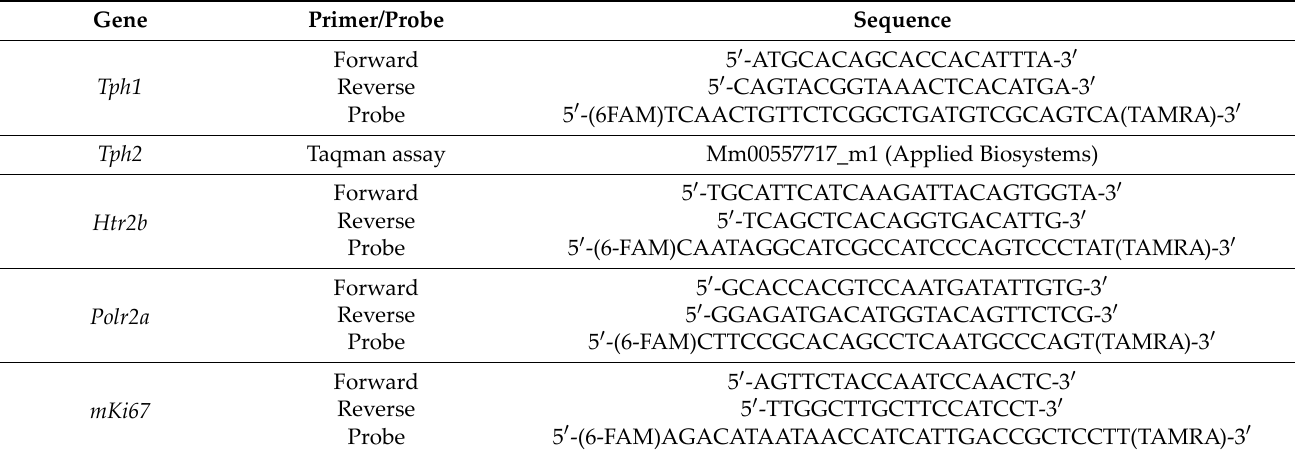
Table 1. Primers and probes used for quantitative